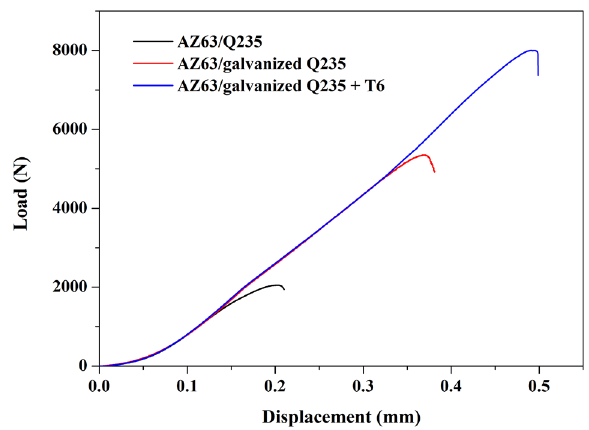
Figure 10. The load–displacement curves. Table 4. Shear strength of AZ63/Q235 metallurgical bonding with different heat treatment times.